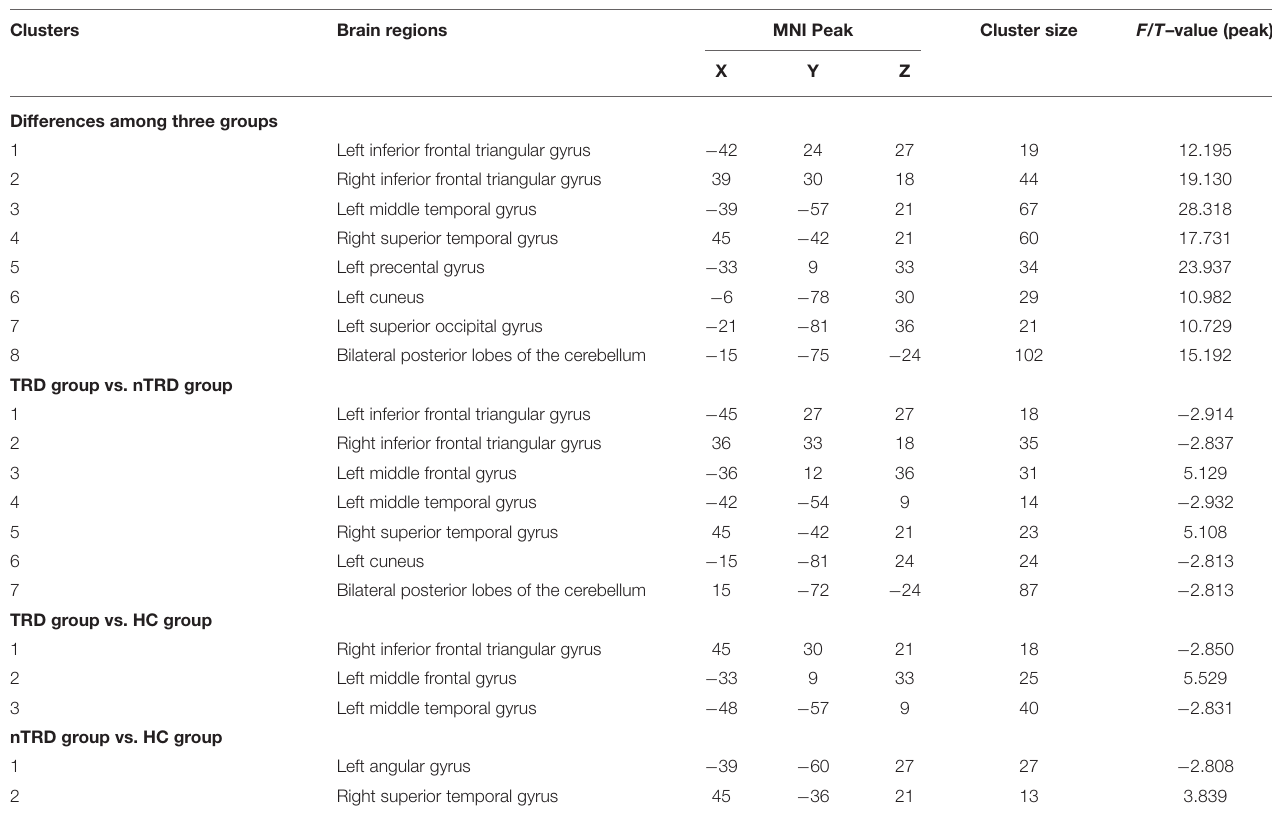
TABLE 2 | ALFF differences in TRD group; nTRD group; and HC